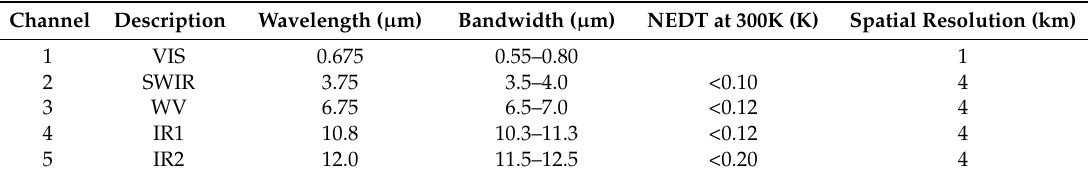
Table 1. Spectral channel characteristics of the Meteorological Imager (MI) on Communication, Ocean and Meteorological Satellite (COMS) (VIS: visible, SWIR: shortwave infrared, WV: water vapor, IR1: infrared 1, IR2: infrared